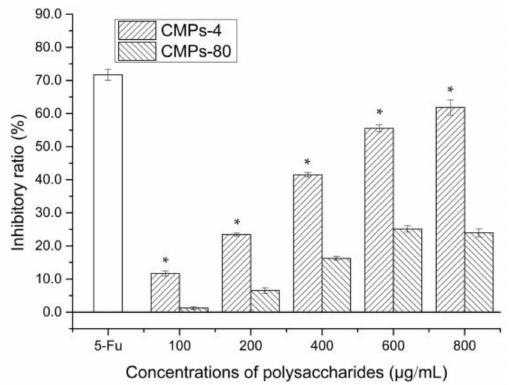
Figure 4. Inhibition effects of CMPs-4 and CMPs-80 by different extraction temperatures on human esophagus cancer Eca-109 cells (mean ± s, n = 3). Note: *, p < 0.05 compared with CMPs-80 under the same concentration.